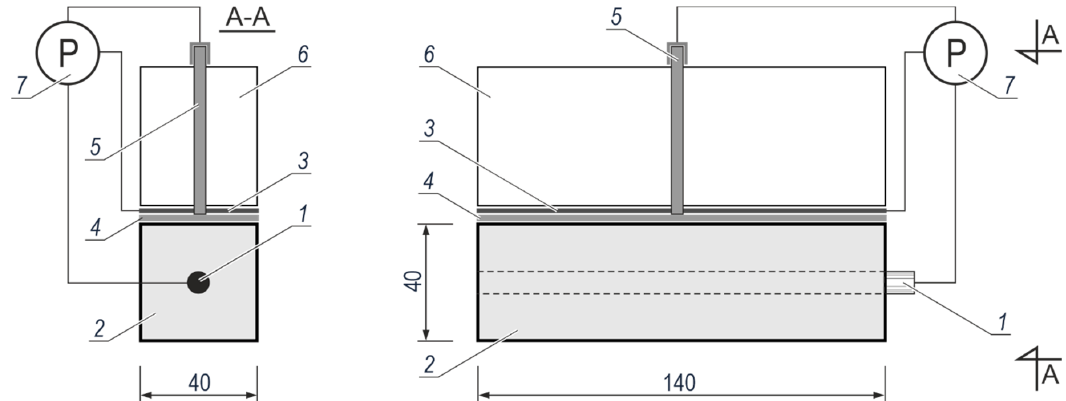
Figure 2. Measuring system for polarization tests of steel reinforcement in concrete: 1—working electrode, 2—concrete, 3—auxiliary electrode, 4—wet felt, 5—reference electrode Cl − / AgCl,Ag, 6—ballast with a guide for reference electrode, 7—potentiostat.